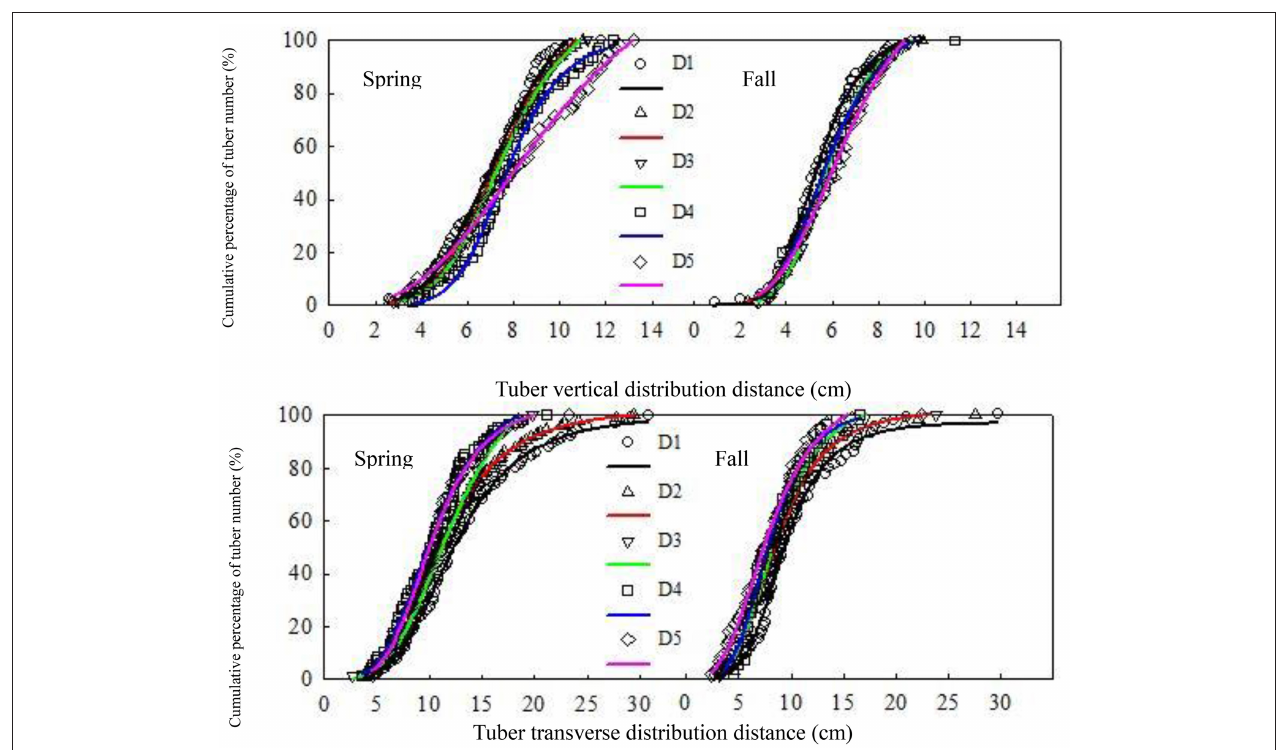
FIGURE 1 | Cumulative percentage of tuber number under different densities in the two growing seasons. Plant densities: D1, 6 × 10 4 strains hm − 2 ; D2, 9 × 10 4 strains hm − 2 ; D3, 12 × 10 4 strains hm − 2 ; D4, 15 × 10 4 strains hm − 2 ; and D5, 18 × 10 4 strains hm − 2